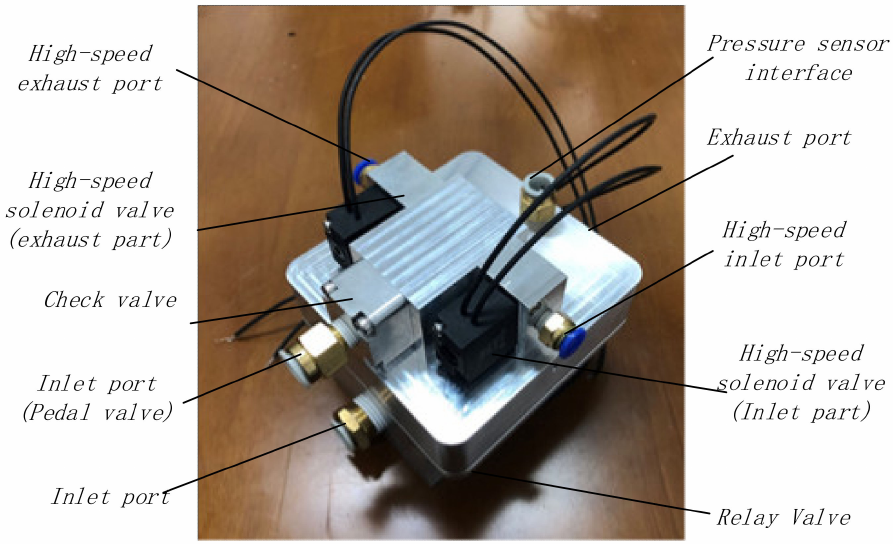
Figure 2. Sample product of an automatic pressure regulating